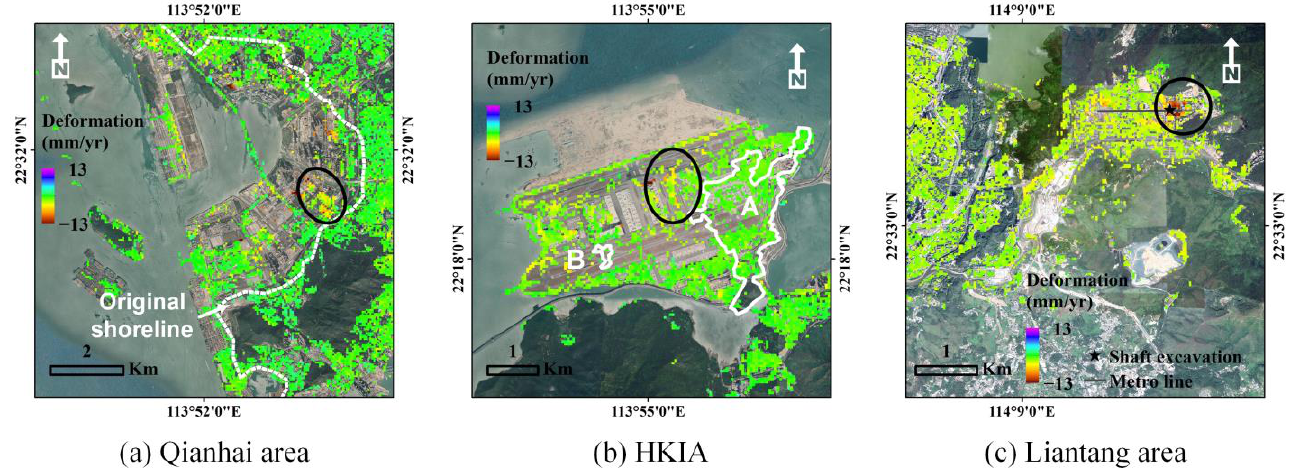
Figure 13. Line-of-Sight (LOS) deformation rates derived after tropospheric correction using ERA5 and spatiotemporal filtering, and superimposed on Google Earth high resolution images. Sub-areas exhibiting significant subsidence are highlighted by black circles. ( a ) Annual deformation rate derived in the ocean-reclaimed land in the Qianhai area, Shenzhen; ( b ) annual deformation rate derived in the ocean-reclaimed land in HKIA; an original rocky island Chek Lap Kok is outlined with white lines and labeled as “A”, and the other original rocky island Lam Chau is drawn with white lines and labeled as “B”; ( c ) annual deformation rate derived in a residential area nearby metro tunneling works at Liantang station, Shenzhen.